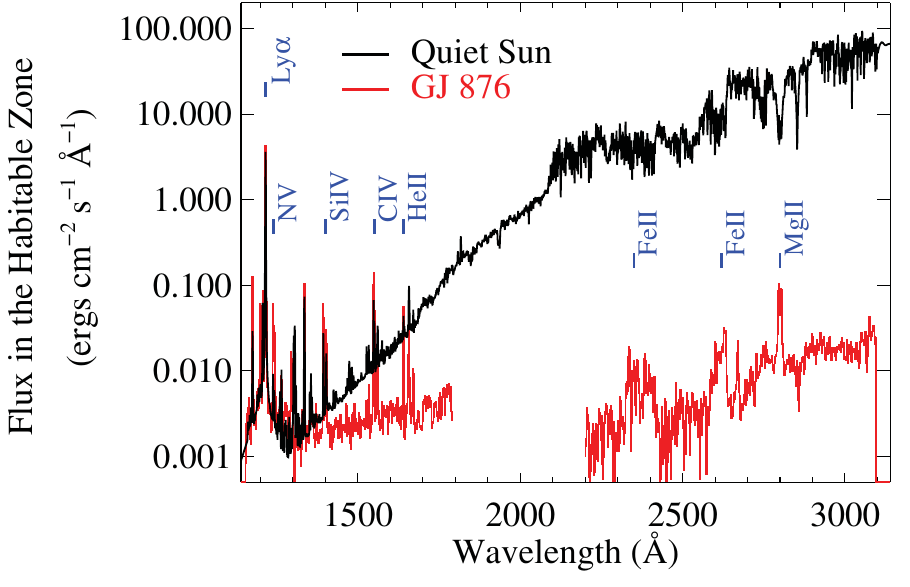
Figure 4. Comparison of the 1150–3140 Å quiet Sun flux incident at Earth (solar flux at 1 AU, black) and the flux observed with the HST/COS instrument from the M4 V star GJ876 at the distance of its habitable zone (0.21 AU, red). Prominent emission lines, in particular H I Lyman- α are marked. The 1800–2200 Å region for GJ876 has been excluded due to low signal to noise. Figure from France et al . with copyright permission